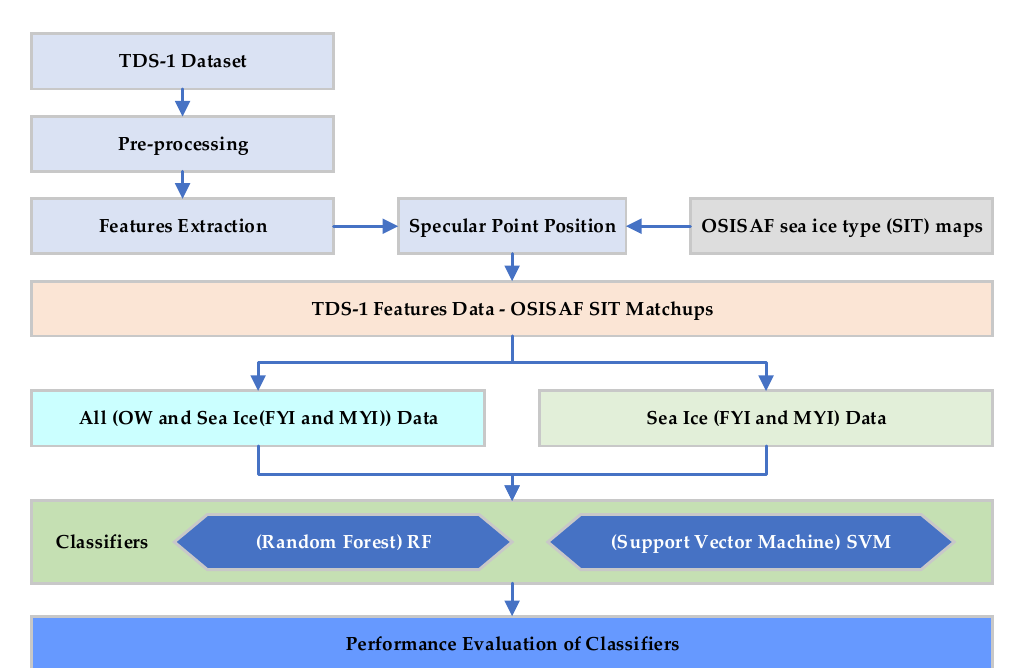
Figure 8. Flowchart of sea ice classification using machine learning classifiers. Firstly, the TDS-1 data is pre-processed (noise elimination, data filter, and selection, delay waveform extraction, and normalization) to extract features. Then the TDS-1 features are matched with the reference sea ice type (SIT) maps from OSISAF. In the first step, the whole datasets are used to classify open water (OW) and sea ice which includes first-year ice (FYI) and multi-year ice (MYI). In the second step, the sea ice datasets are applied to classify FYI and MYI. Finally, the OW-Sea Ice and FYI-MYI classification results are evaluated against the OSISAF SIT.